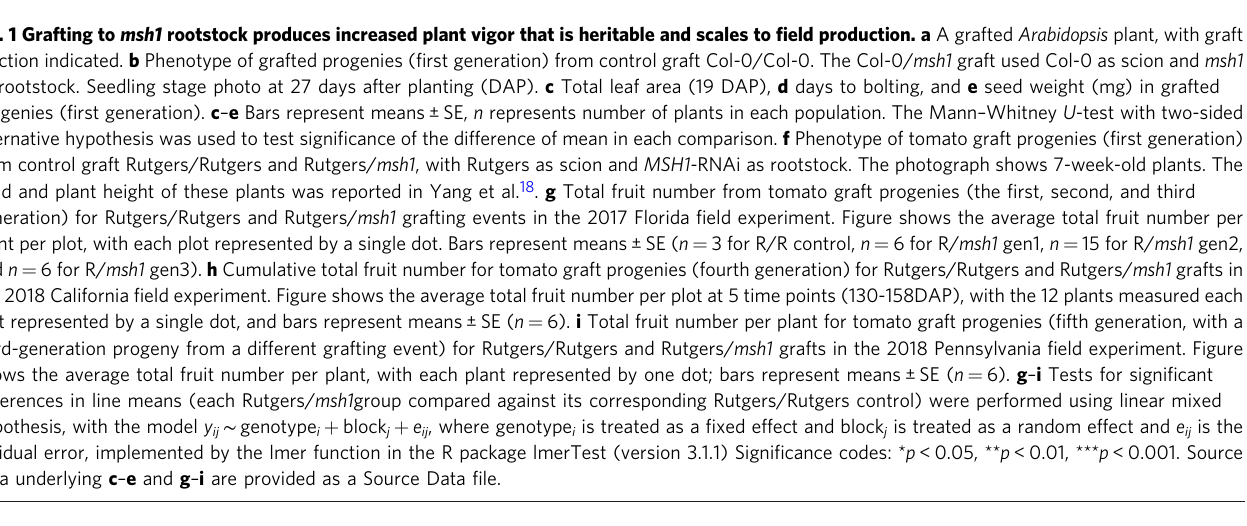
Fig. 1 Grafting to msh1 rootstock produces increased plant vigor that is heritable and scales to fi eld production. a A grafted Arabidopsis plant, with graft